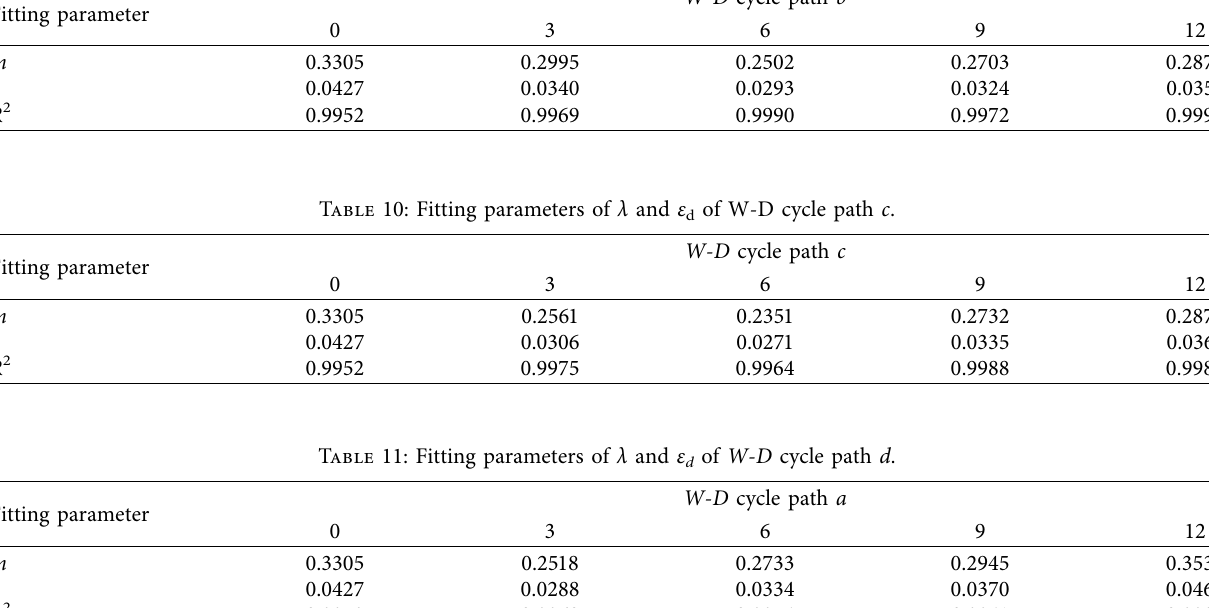
d of W - D cycle path b .